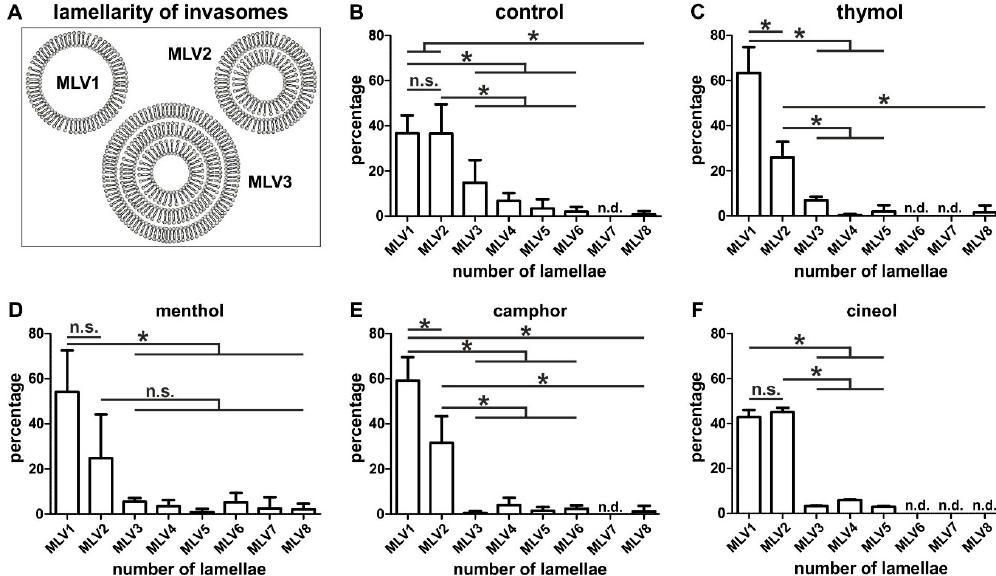
Figure 4. Characterization of lamellarity of the produced terpenoid-comprising invasomes. ( A ) Schematic view of individual types of lamellar phase lipid bilayers. (B) Without the addition of a terpenoid (control, B ), mostly unilamellar and bilamellar vesicles were formed in equal